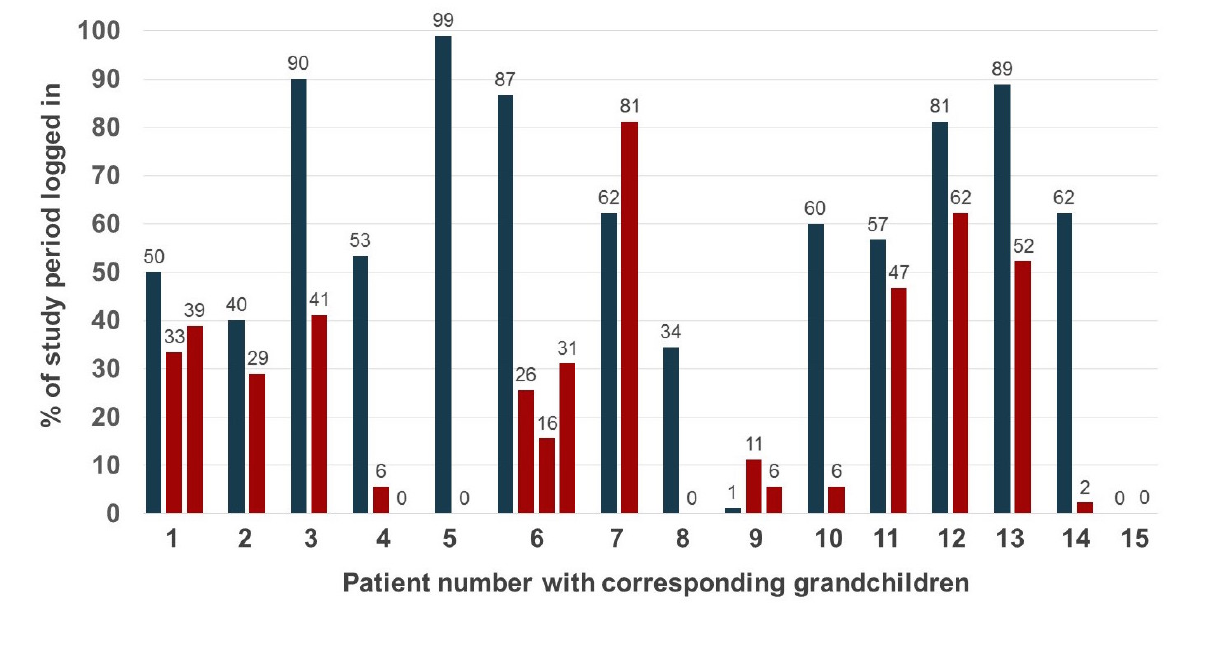
Figure 5. Average percentage of the days logged in to the app by the patients (blue) and grandchildren (red) over the study period of 90